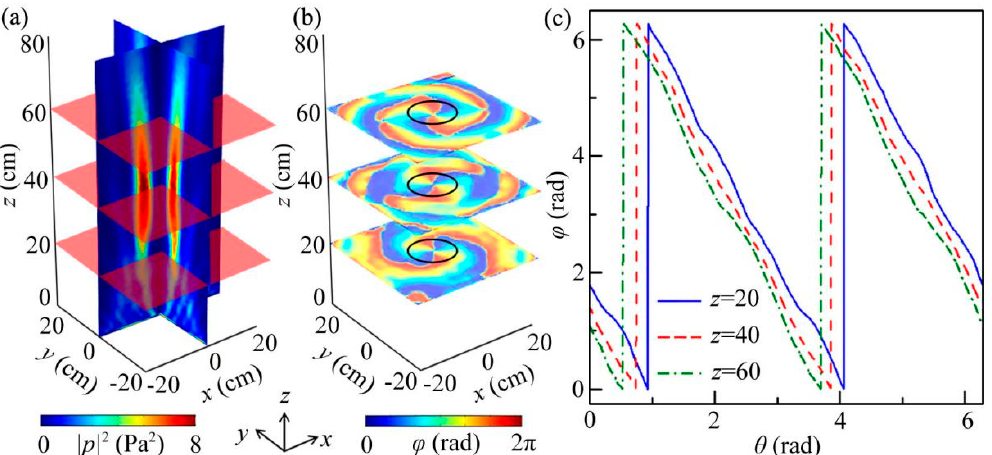
Figure 6. The performance of the reflected ABV beam with n = 2 at 9.0 kHz. ( a ) Simulated 3D reflected intensity distribution of the ABV beam created by the quasi-3D metasurface, and its corresponding reflected ( b ) phase distribution at 3 cross sections z = 20, 40, and 60 cm. ( c ) Phase delays around in a circle with the radius of 6 cm (black open circles in (b)) as a function of θ at the 3 cross sections.